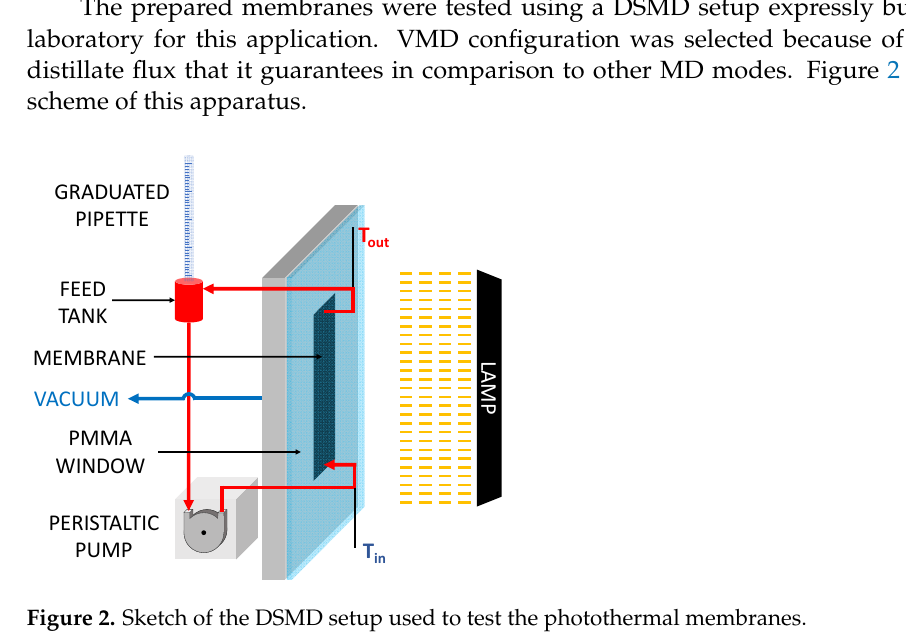
Figure 2. Sketch of the DSMD setup used to test the photothermal membranes.